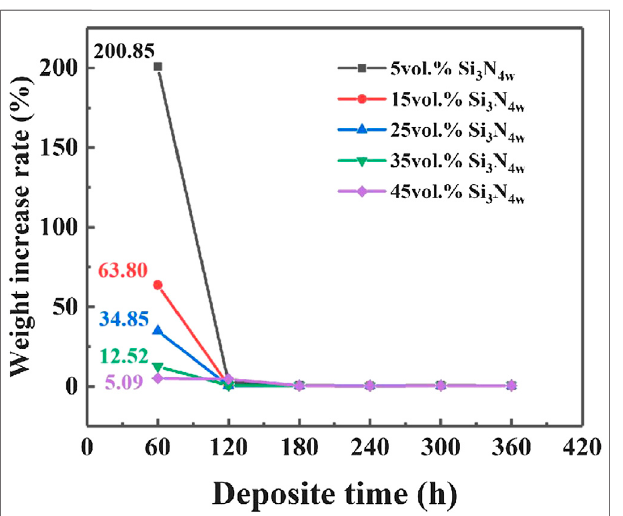
FIGURE4| Bulkdensityandopenporosityof fi vekindsofSi 3 N 4w /Si 3 N 4